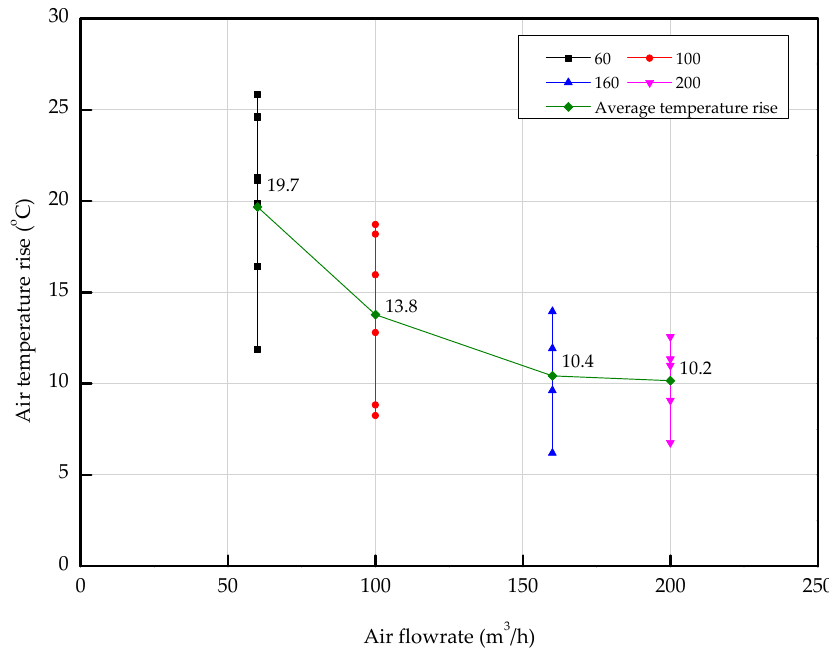
Figure 6. Effect of the air flow rate on the rise in air temperature between inlet and outlet.